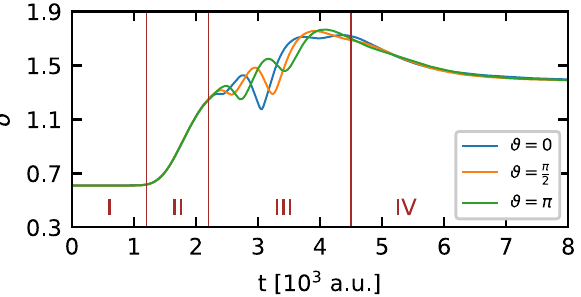
Figure 7. Influence of the relative phase ϑ on the non-classicality parameter for the DSC-state with the quality parameter Ŵ = 1 , which interacts with the Gaussian barrier.